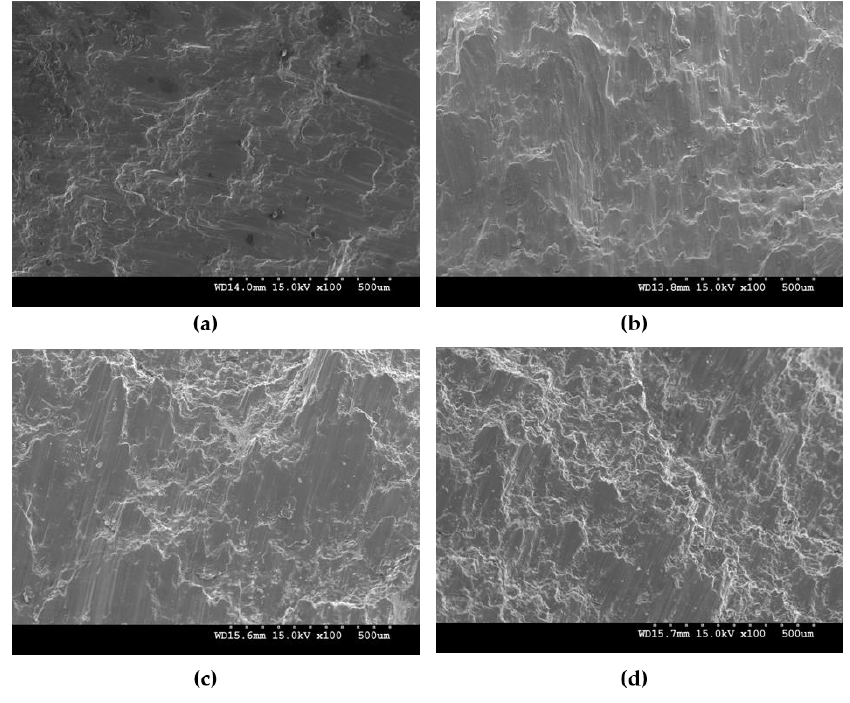
Figure 3. Fractographs after compressive loading of: ( a ) Pure Mg; ( b ) Mg-0.5 vol % Sm 2 O 3 ; ( c ) Mg-1 vol % Sm 2 O 3 , and ( d ) Mg-1.5 vol % Sm 2 O 3 .